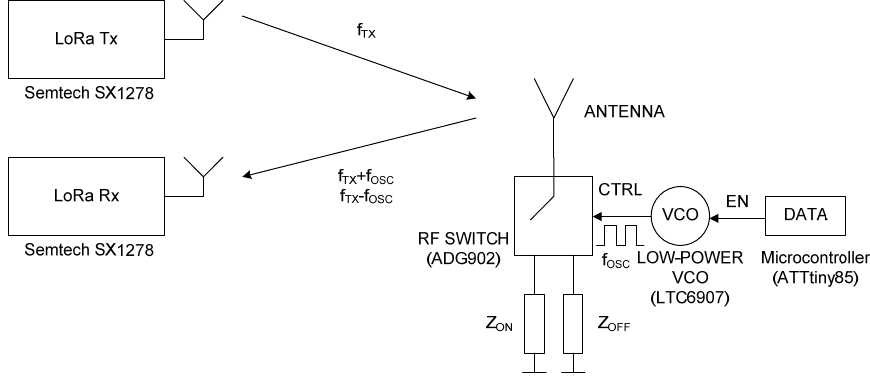
Figure 1. Block diagram of the backscattering system.